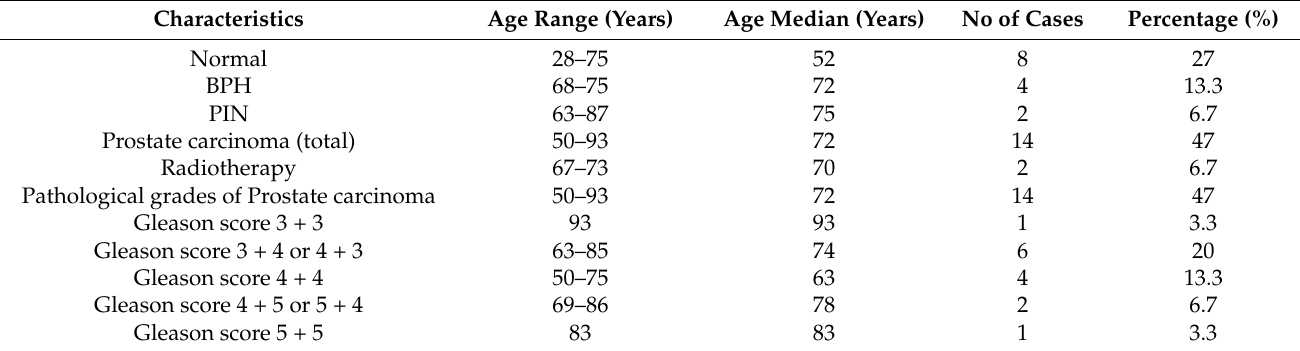
Table 2. Patient (male) Characteristics (N = 30).